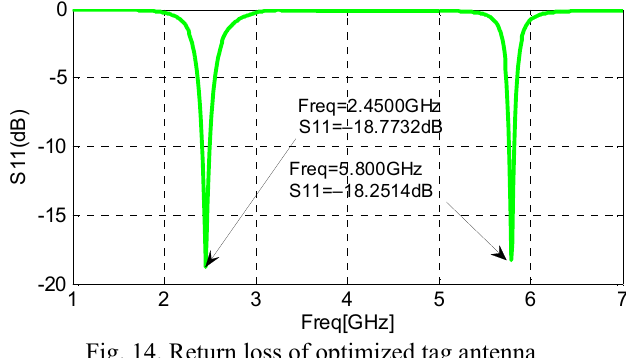
Fig. 14. Return loss of optimized tag antenna